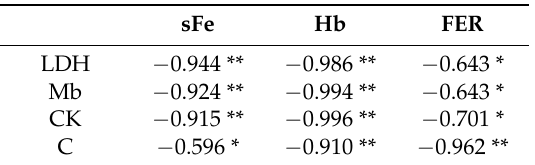
Table 4. Correlations between hematological biomarkers (serum iron (sFe), hemoglobin (Hb) and ferritin (FER)) and muscular biochemical markers (lactate dehydrogenase (LDH), myoglobin (Mb), creatine kinase (CK) and cortisol (C)). sFe Hb FER LDH − 0.944 ** − 0.986 ** − 0.643 * Mb − 0.924 ** − 0.994 ** − 0.643 * CK − 0.915 ** − 0.996 **